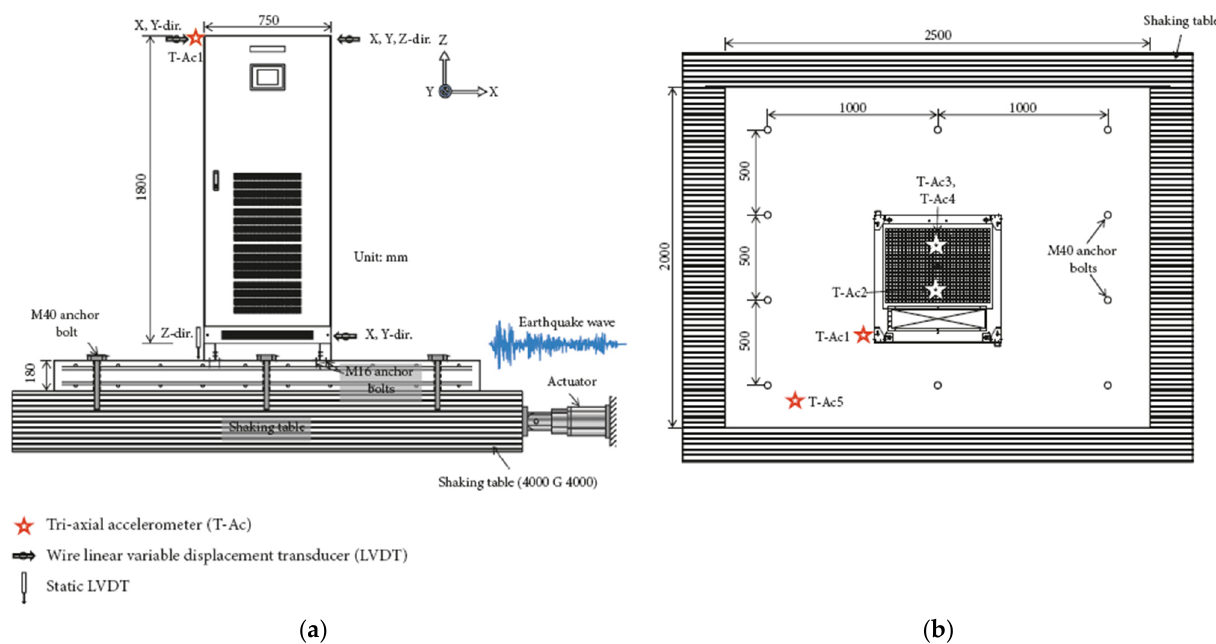
Figure 10. Typical shaking table test setup: ( a ) front view and ( b ) plan view [85].